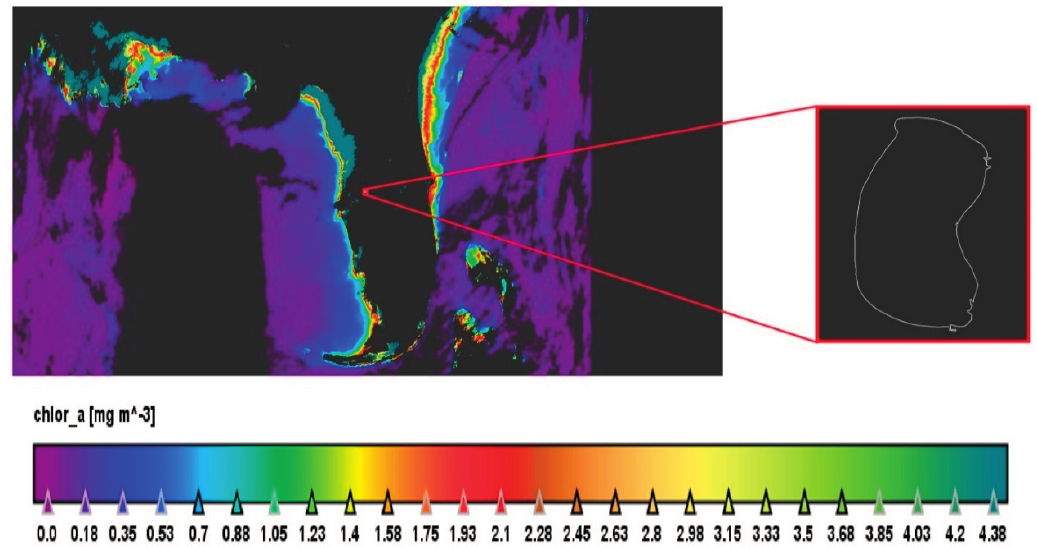
Figure 4. OC3M application using SeaDAS 7.02 on a MODIS-Aqua L0